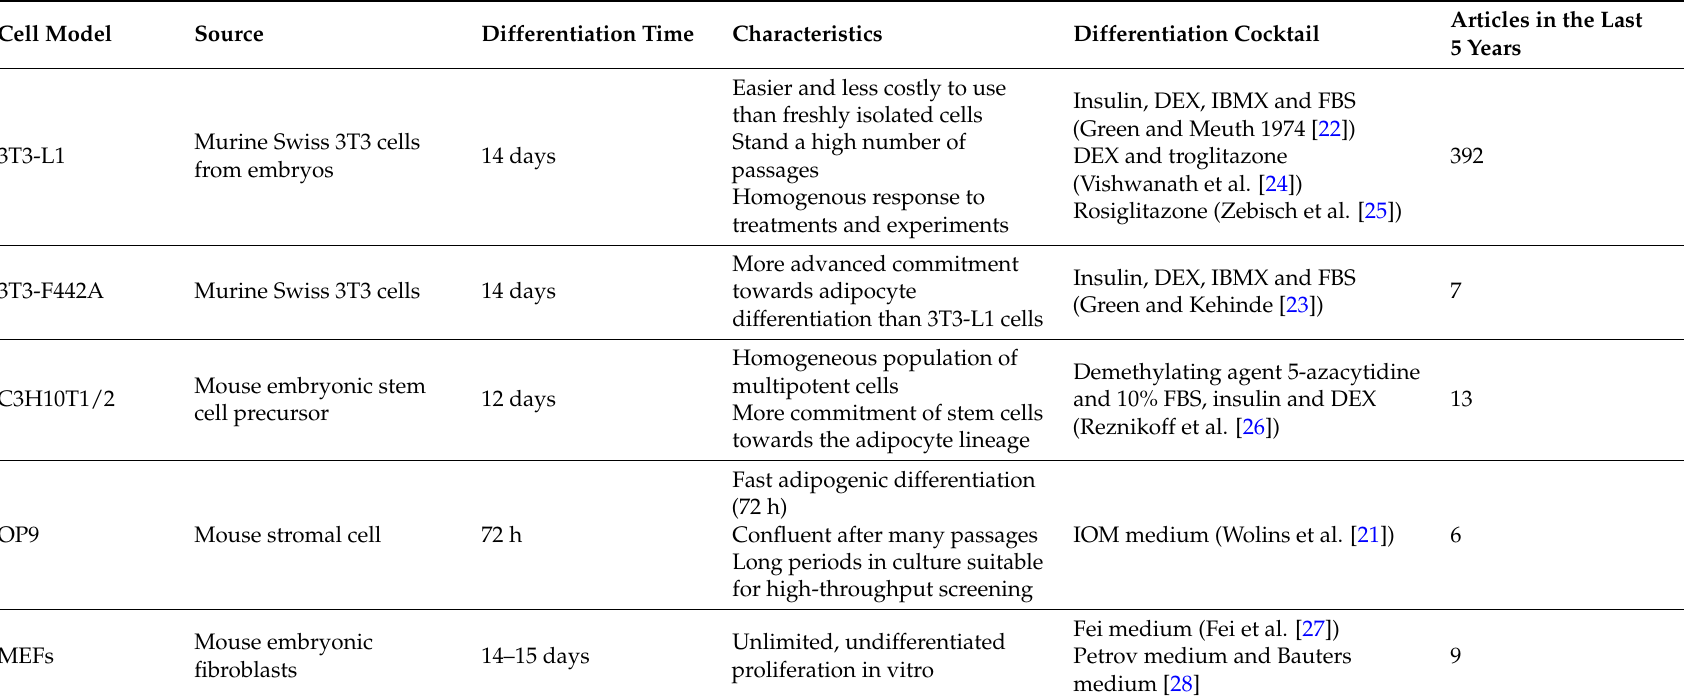
Table 1. Mouse cell lines to study the adipogenesis